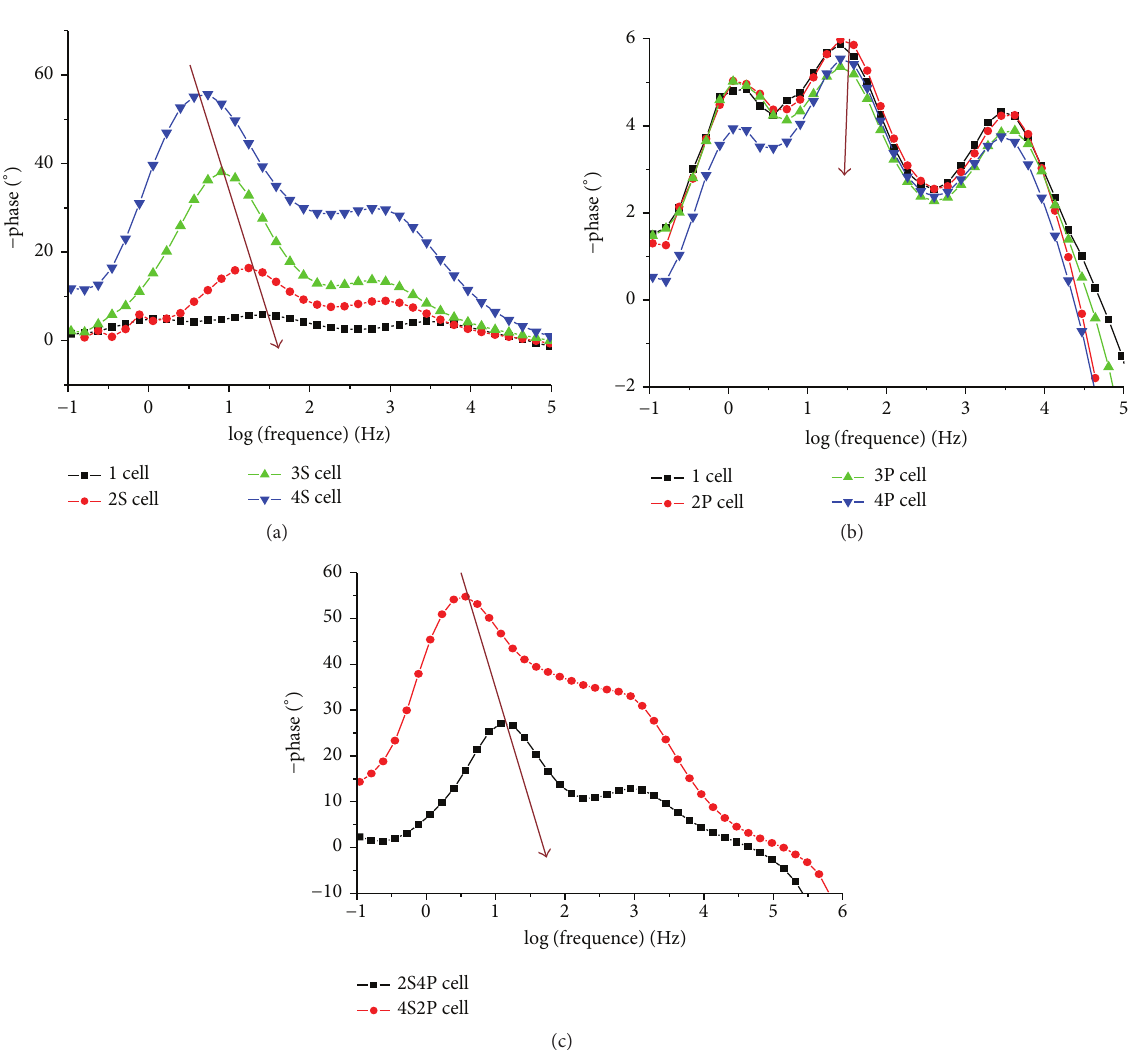
Figure8:TheBodephaseplotsbasedondifferentDSSCmodelassemblies(a)seriesmodules;(b)parallelmodules;(c)series-parallelmodules.